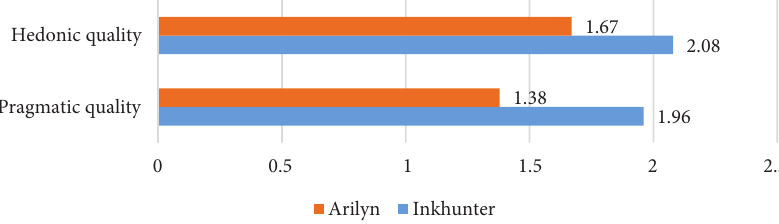
Figure 3. Evaluation results of augmented reality applications Inkhunter and Arilyn according to hedonic and pragmatic quality (source: created by the